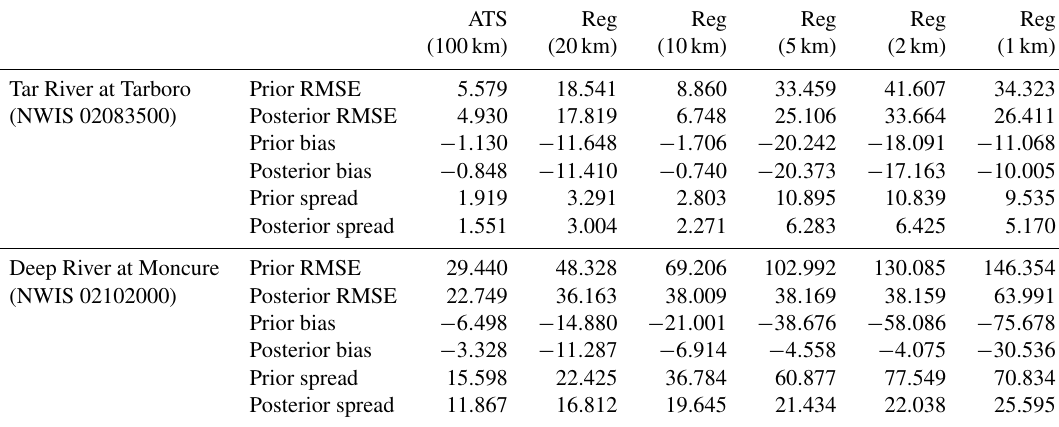
Table 2. Comparison of ATS and regular (Reg) localization at Tar River and Deep River. The localization radius used in the ATS approach is 100km. For the regular localization approach, five different radii are tested, namely 20, 10, 5, 2, and 1km. The metrics used to compare the schemes are prior and posterior RMSE, prior and posterior bias, and prior and posterior spread. The metrics (in cubic meters per second) are all averaged over the entire simulation